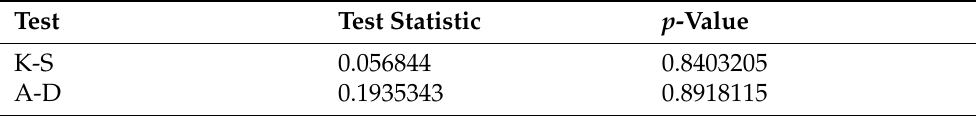
Table 6. Goodness-of-fit for Eastern Cape (1900–2017).